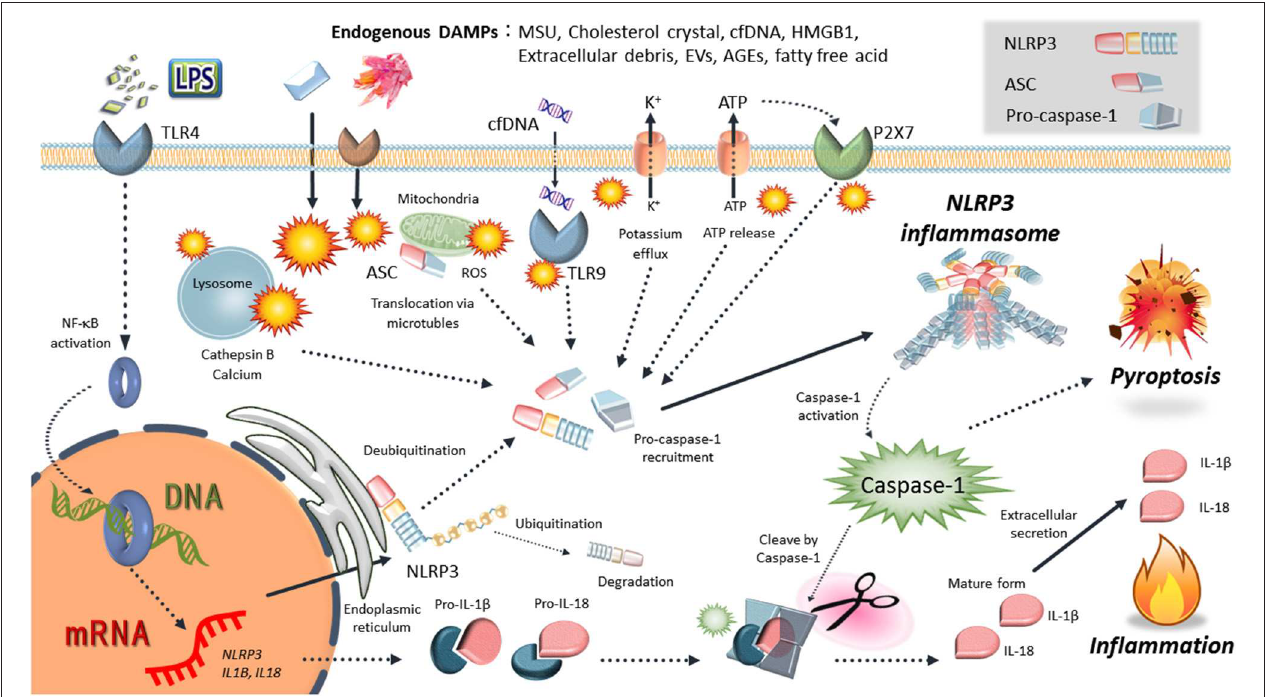
FIGURE 1 | Schematic mechanisms of NLRP3 inflammasome activation. NLRP3 is activated by various endogenous DAMPs: uric acid crystals (MSU), cholesterol crustal, cell-free DNA (cfDNA), high-mobility group box 1 (HMGB1), extracellular debris, extracellular vesicles (EVs), advanced glycation end-products (AGEs), and free fatty acid. Various events such as intracellular ATP release, NLRP3 deubiqutination, relocalization, reactive oxygen species (ROS) generation, mitochondrial dysfunction, lysosome rapture, and cathepsin release occur depending on the effects of damage-associated molecular patterns (DAMPs). Then, inflammasome components, including NLRP3, ASC, and procaspase-1, form the NLRP3 inflammasome complexes. Finally, activated caspase-1 induces the inflammatory form of cell death known as pyroptosis and cleaves the precursor cytokines pro-IL-1 β and pro-IL-18, generating the biologically active cytokines IL-1 β and